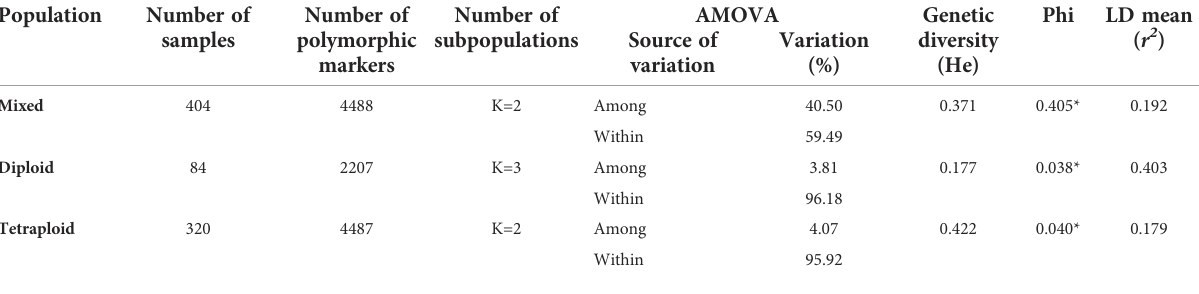
TABLE 1 Genetic diversity, structure population and linkage disequilibrium statistics in potato populations. Population